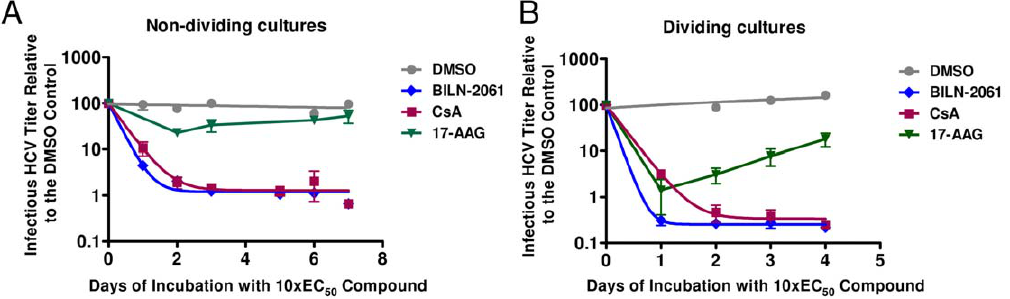
Figure 6. 17-AAG reduces HCV titer by slowing cellular growth. (A) Non-dividing HCV-infected cultures were treated with 10 6 EC 50 for each compound. Subsequently, extracellular HCV titer was quantified at various times in the presence of DMSO (circles), 0.35 m M HSP90 inhibitor 17-AAG (triangles), 1.30 m M cyclosporin inhibitor CsA (squares), or 1.40 m M HCV protease inhibitor BILN-2061 (diamonds). The DMSO data were fit to a linear equation. The CsA and BILN-2061 data were fit to second-order exponential equations. The 17-AAG data could not be fit to first or second order exponential equations. (B) Dividing HCV-infected cultures were treated with 10 6 EC 50 compound. Subsequently, extracellular HCV titer was quantified at various times in the presence of DMSO (circles), 0.35 m M HSP90 inhibitor 17-AAG (triangles), 1.30 m M cyclophilin inhibitor CsA (squares), or 1.40 m M HCV protease inhibitor BILN-2061 (diamonds). The DMSO data were fit to a linear equation. The CsA and BILN-2061 data were fit to second-order exponential equations. The 17-AAG data could not be fit to first or second order exponential